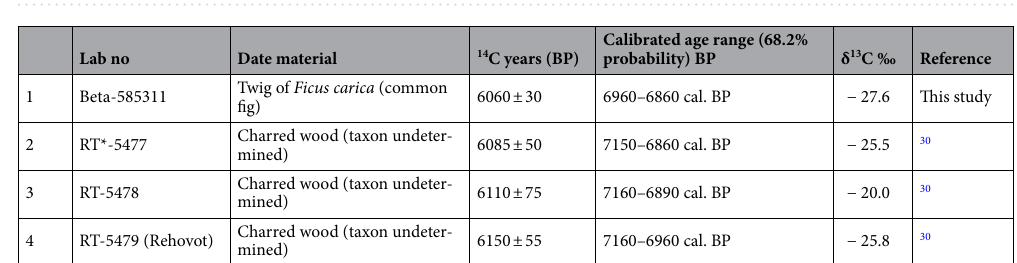
Table 2. Radiocarbon dates of charred wood from Area C, Chalcolithic Tel Tsaf. *RT = Weizmann Institute of Science in Rehovot, Israel.